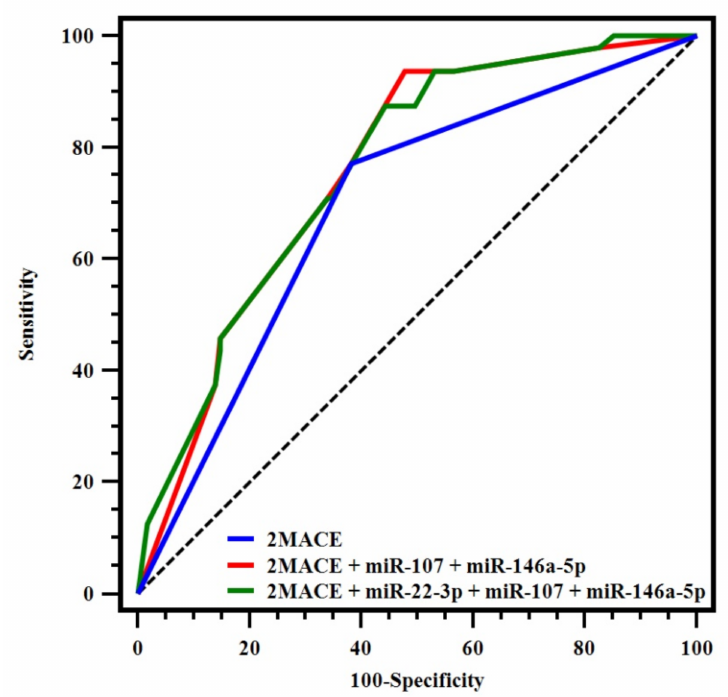
Figure 2. Receiver operating characteristic-curves for the 2MACE score and the 2MACE models with the addition of